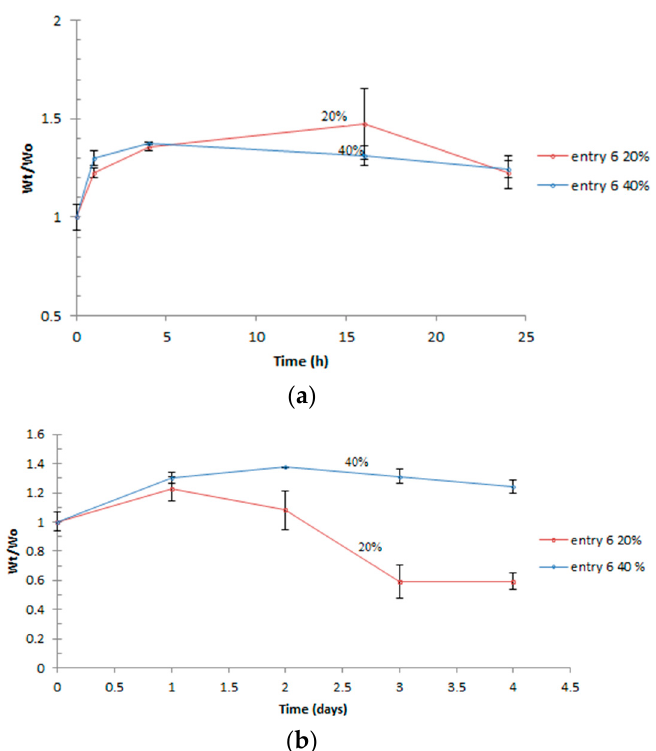
Figure 5. Swelling studies performed on chemically crosslinked 20% and 40% hydrogels using R6 (entry 6, Table 1) in PBS buffer (1 M, pH 7.4) at 37 °C after ( a ) 24 h and ( b ) 4 days.